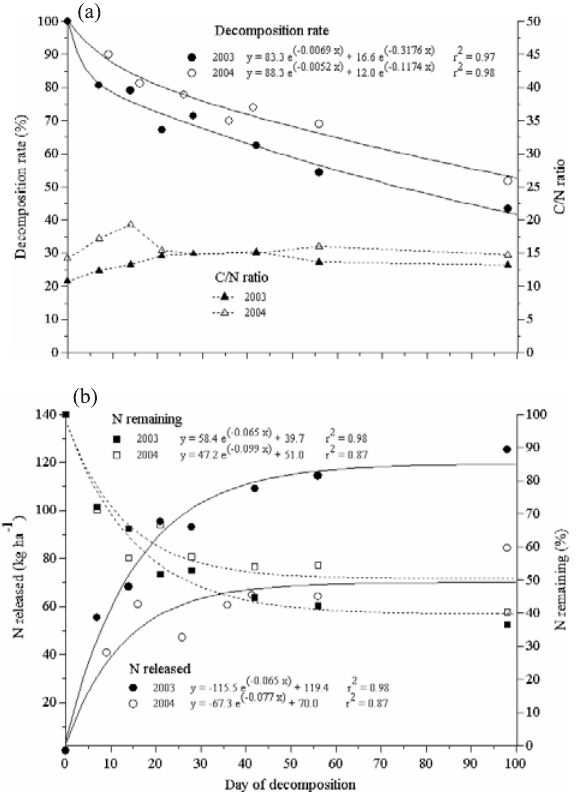
Figure 1. Decomposition rate of hairy vetch residues and C/N ratio (a), released N and remaining N percentage in residues (b) after 100 days of decomposition in 2003 and 2004. These legume residues were not